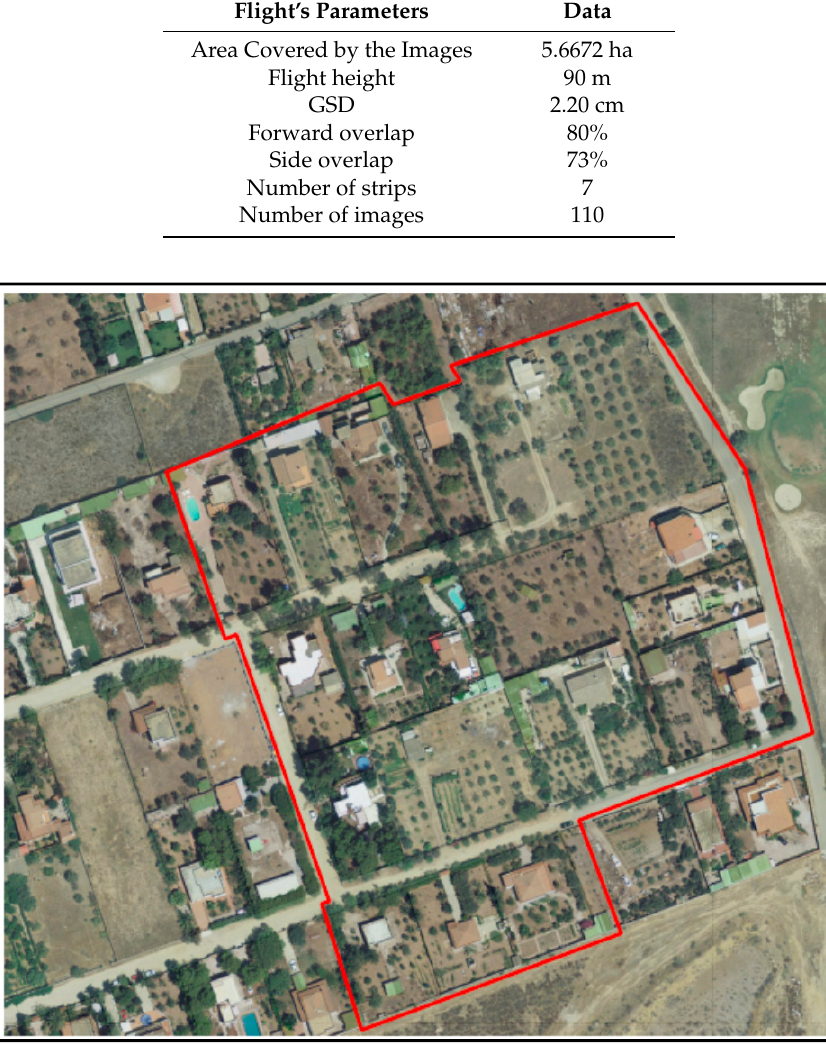
Figure 5. Flight path. The numbers indicate the waypoints of the strips. In order to georeference the point clouds, we used five GCPs positioned on the roads of the surveyed areas. This choice was dictated by the impossibility of placing GCPs at different heights, such as on the roofs of buildings, as suggested by scientific literature, for reasons of privacy, since the buildings are privately owned. The good distribution of GCPs is of high importance not only for the image orientation, but also for the prevention of block deformation effects that may result from the remaining systematic errors in the camera calibration [35,36]. The coordinates of the points were determined using a GNSS RTK survey in the ETRF2000 datum. The flight was performed 13 November 2016 at 14:00. The time from take-off to landing was about 8 min and 30 s. 3.1.1. Image Processing Agisoft Photoscan Processing